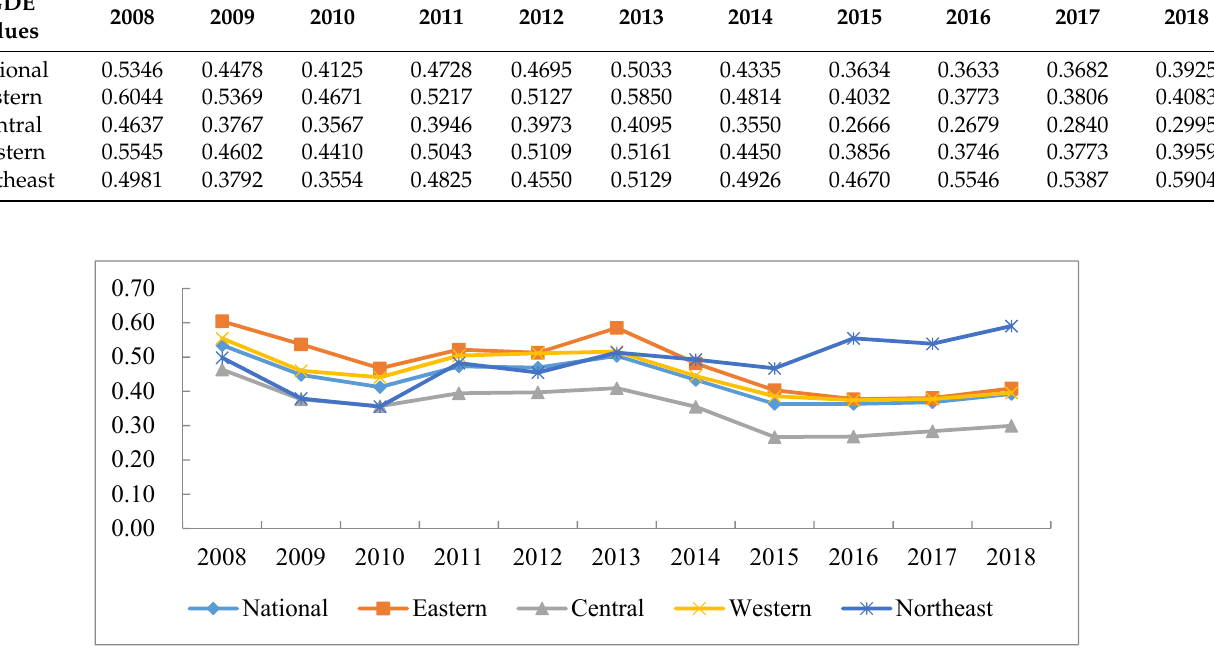
Figure 1. Changes in IGDE in China from 2008 to 2018.